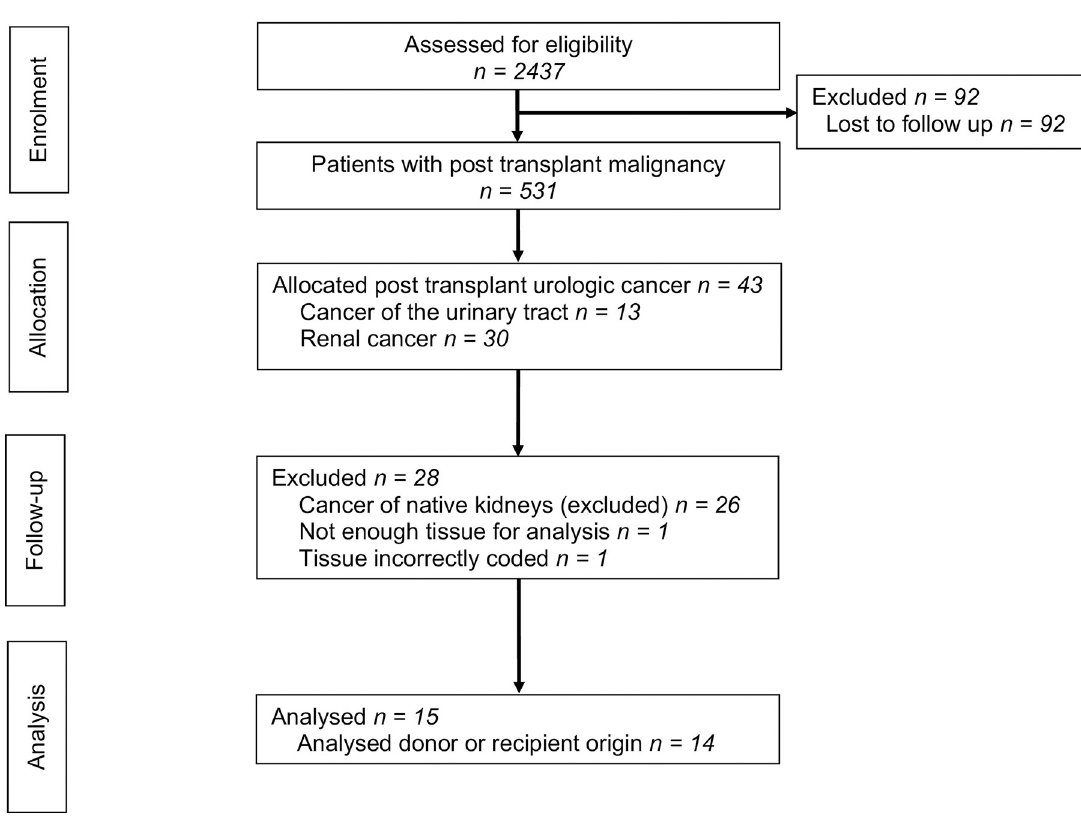
Fig 1. Flow diagram of donor-derived urologic cancers in renal transplanted